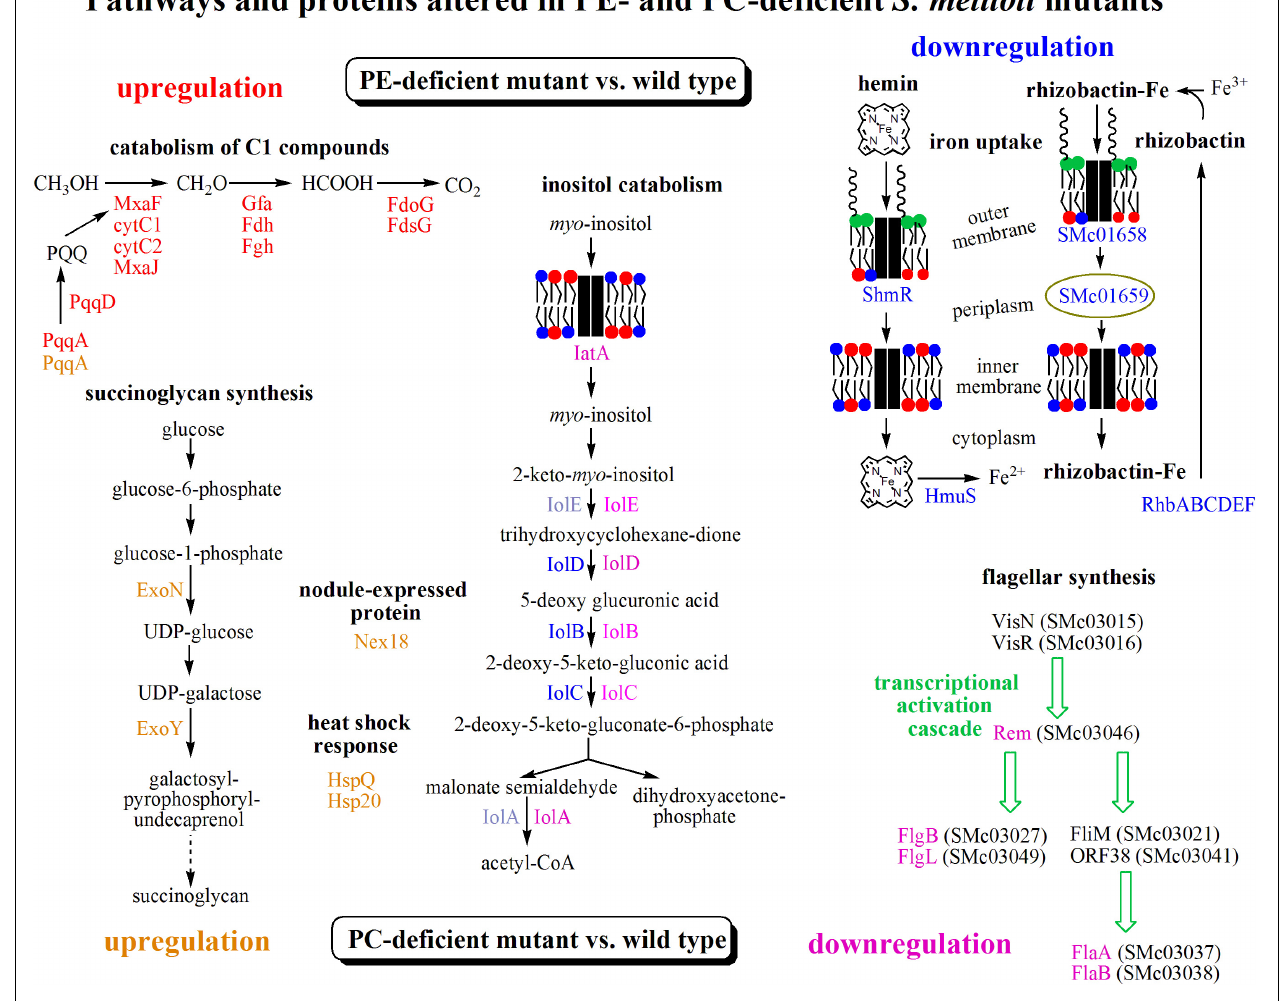
FIGURE 4 | Transcriptomic results suggest differently altered pathways in PE- and PC-deficient mutants of S. meliloti . Comparison of transcript profiles of phospholipid-deficient mutants with S. meliloti wild type suggests that a pathway for C1 catabolism is upregulated (red) and pathways for inositol catabolism and iron uptake are downregulated (blue) in the PE-deficient mutant CS111 and that the pathway for succinoglycan biosynthesis and heat shock response are upregulated (orange) and pathways for inositol catabolism and flagellar synthesis are downregulated (pink) in the PC-deficient mutant OG10017. Proteins from altered transcripts are highlighted with the respective colors. For details see text, Tables 2 , 3 , Supplementary Tables 1, 2